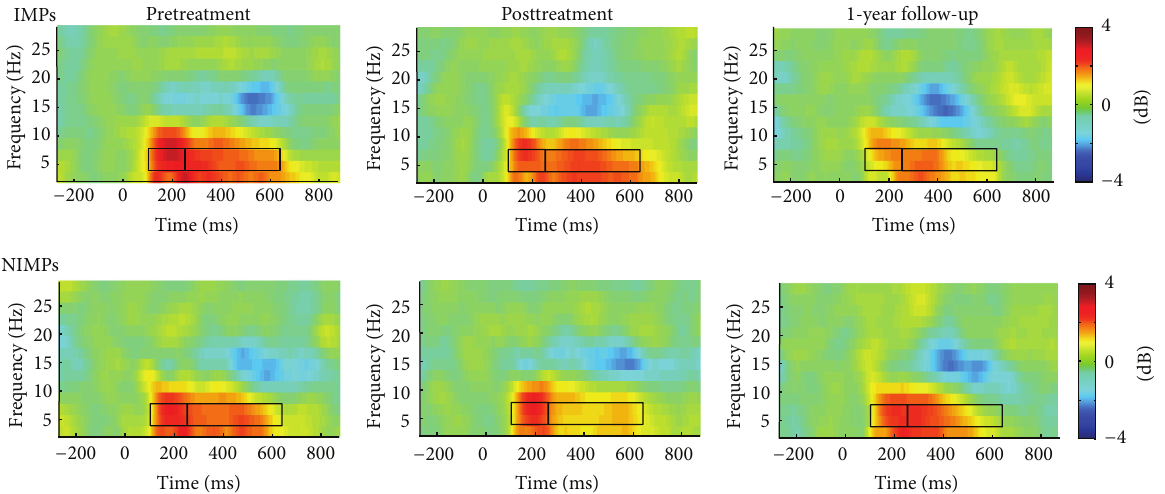
Figure 3: Time-frequency plots showing theta power (in dB) at each session (pretreatment, posttreatment, and follow-up) for improvers (IMPs) and nonimprovers (NIMPs) for our analysis classifying improvement status by externalizing changes. Boxes delineate the early and later peak of the theta band.